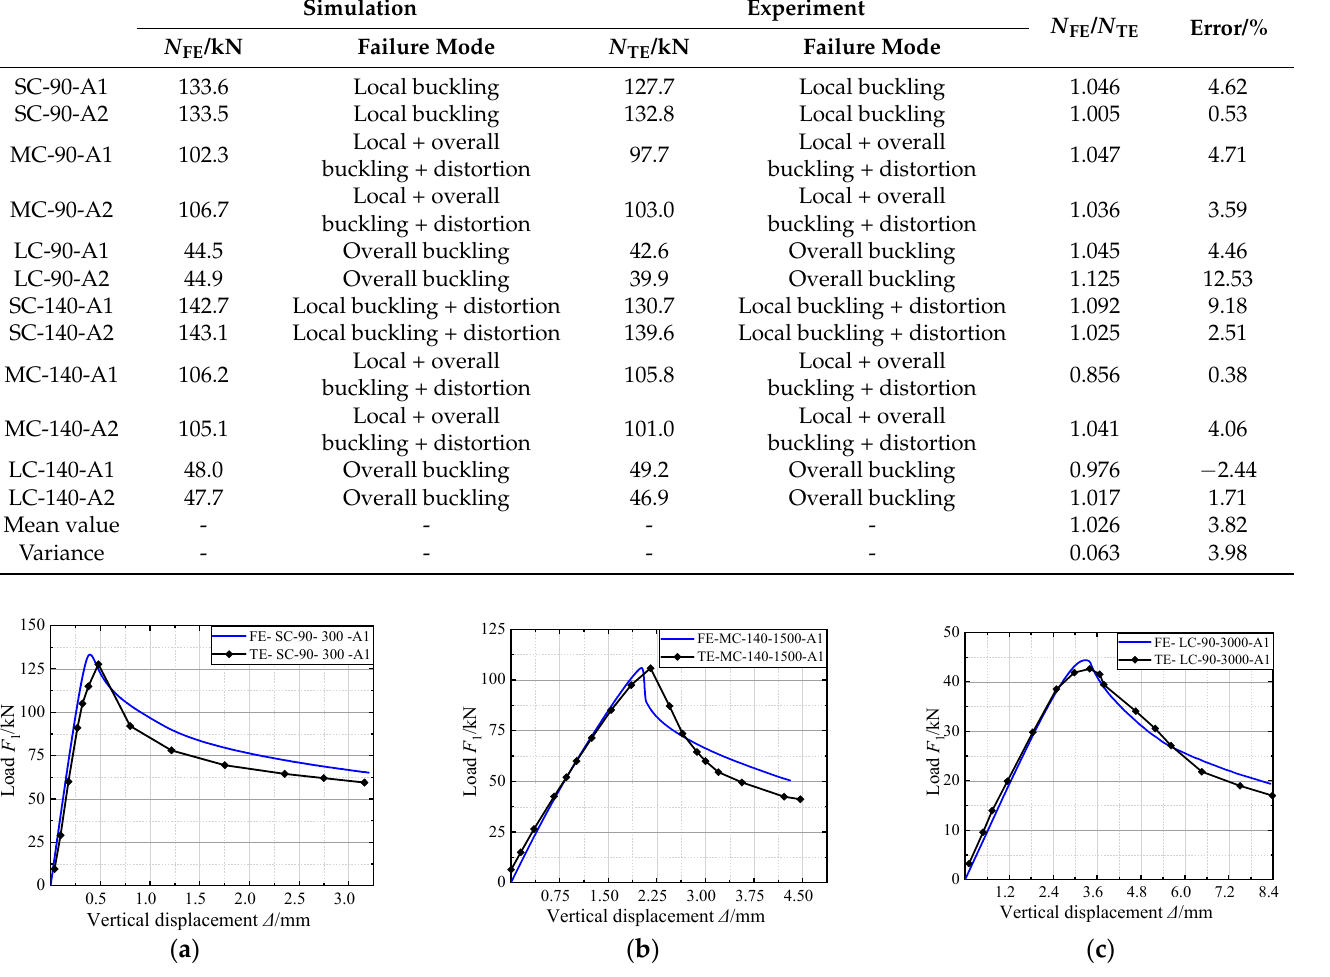
Figure 5. Load–vertical displacement relationship curves of the C-steel combined I-section columns ( a ) SC-90-300-A1 ; ( b ) MC-140-1500-A1 ; ( c ) LC-90-3000-A1 .